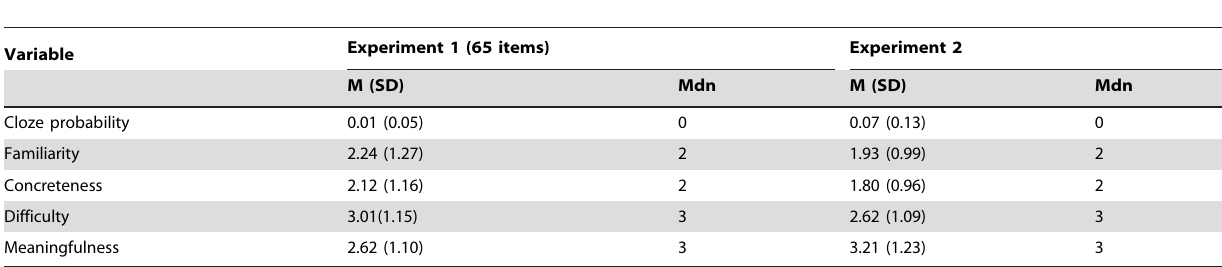
Table 6. Descriptive statistics of items included both in Experiment 1 and Experiment